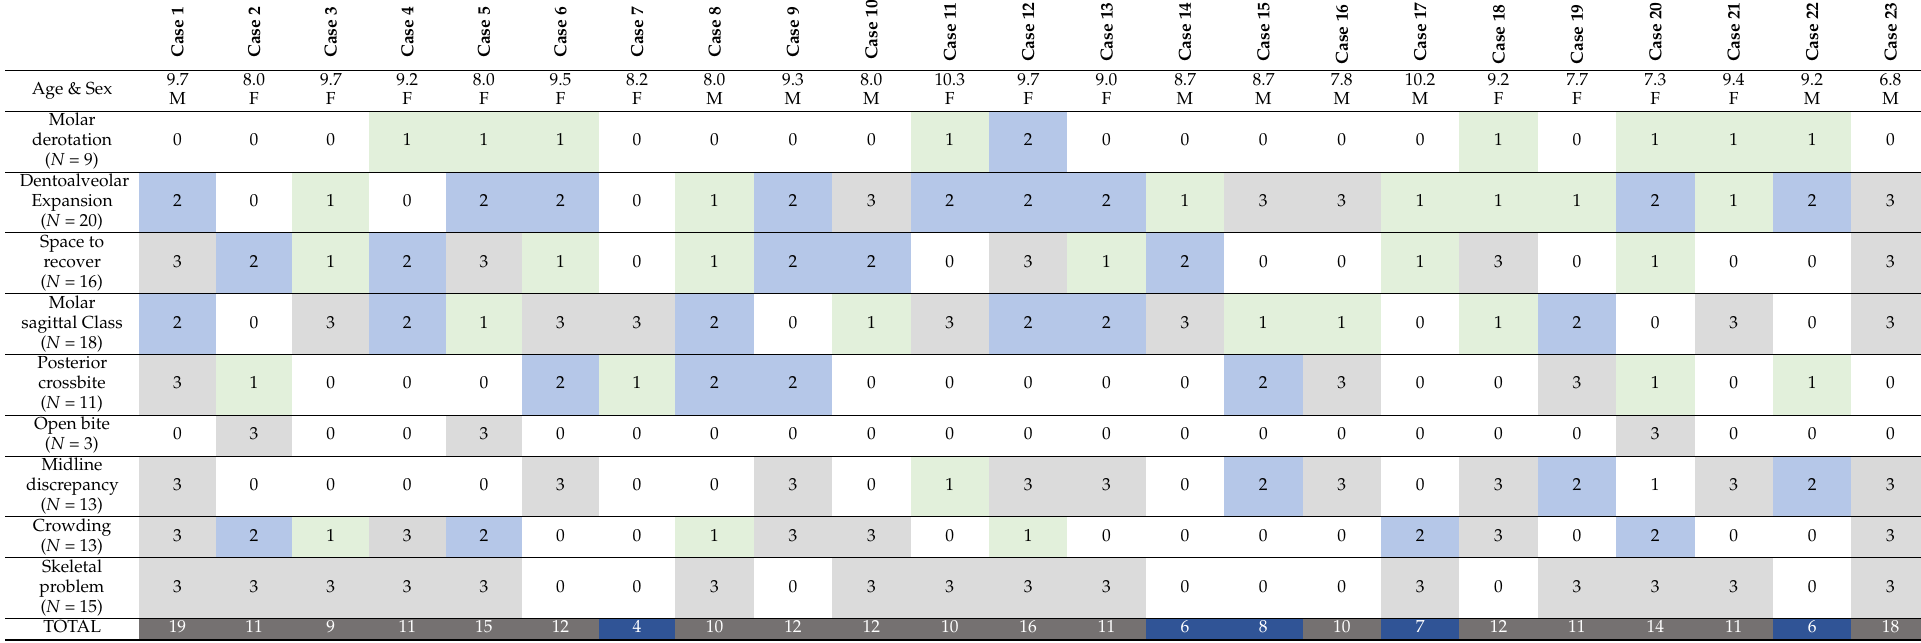
Table 2. Qualitative evaluations of each objective and the global complexity classification of every